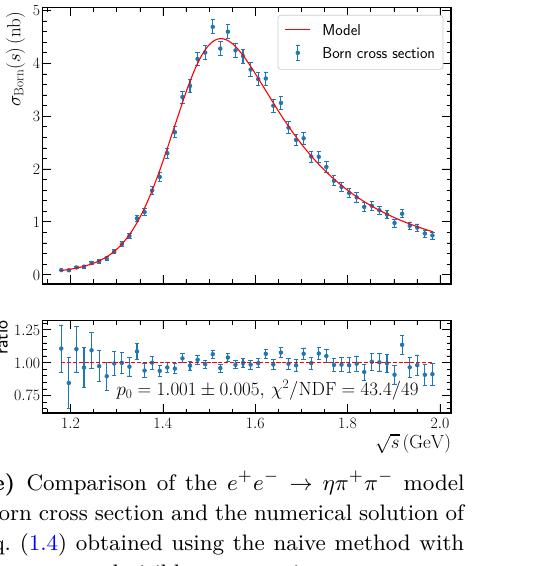
(f) Comparison of the e + e − → ηπ + π − model Born cross section and the numerical solution of eq. (1.4) obtained using the naive method with the model visible cross section.